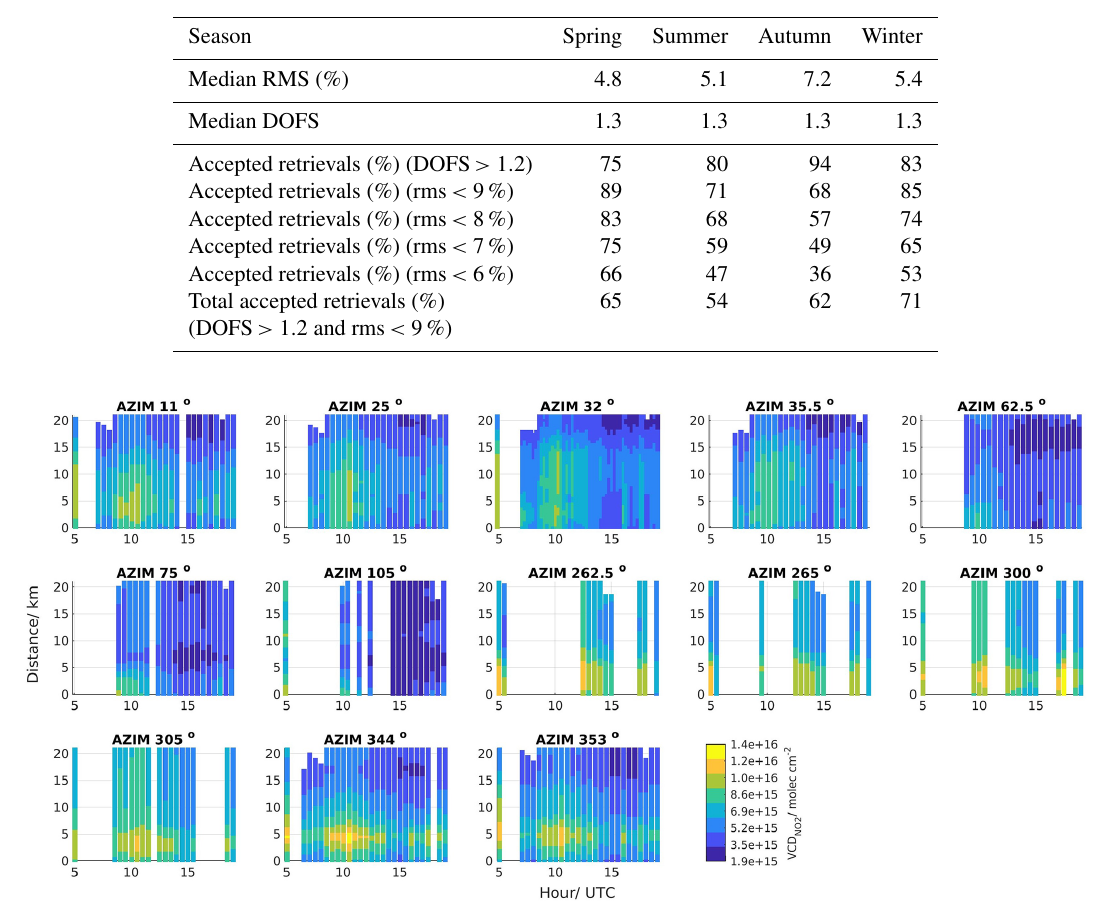
the corresponding TROPOMI NO 2 VCD. It should be noted that the MAX-DOAS segments are weighted by their rela- tive length inside each pixel. APEX observations located in- side each TROPOMI pixel were used to assign one APEX NO 2 VCD value per pixel. Maps of co-located TROPOMI, AEROMOBIL, averaged MAX-DOAS, and averaged APEX NO 2 VCDs for 28 June 2019 are shown in Fig. 19. Two maps of APEX and MAX-DOAS observations are presented: one with APEX and MAX-DOAS in their initial resolution and one with spatially averaged APEX and MAX-DOAS obser- vations in the area covered by a TROPOMI pixel. The NO 2 plume as detected by APEX is covering the NW, N, and NE parts of the Brussels region. MAX-DOAS successfully de- tected the same NO 2 plume in the NW and N but not in the NE direction. The correlation and agreement between APEX and MAX-DOAS observations are very good ( R = 0 . 89 and s = 1 .